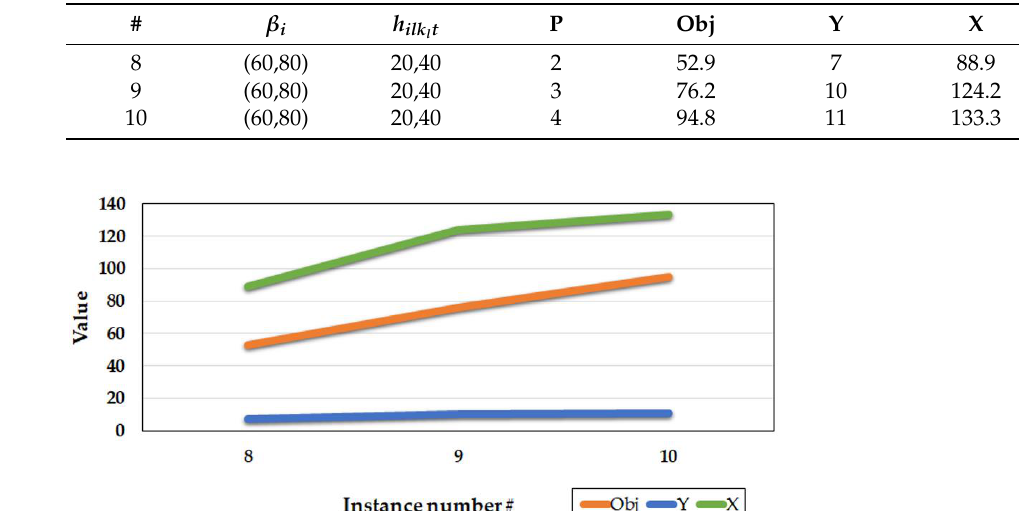
Table 3. Computational results to observe the effect of the increasing number of located facilities.